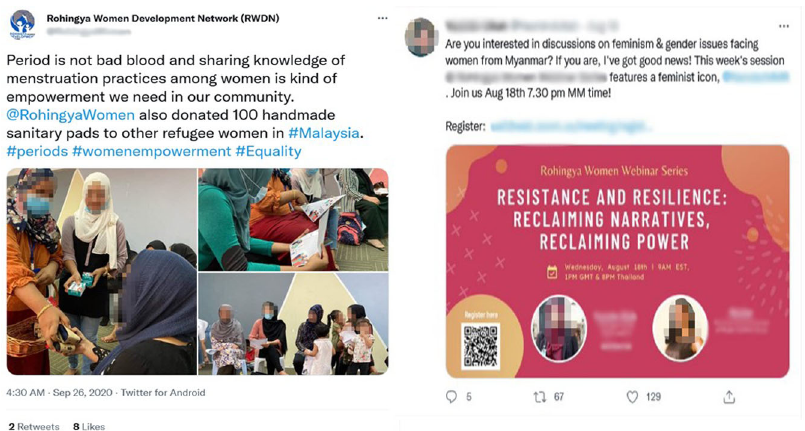
Fig. 7 Rohingya women bring gender issues to the forefront of their struggle. Rohingya women activists raising gender awareness on social media.